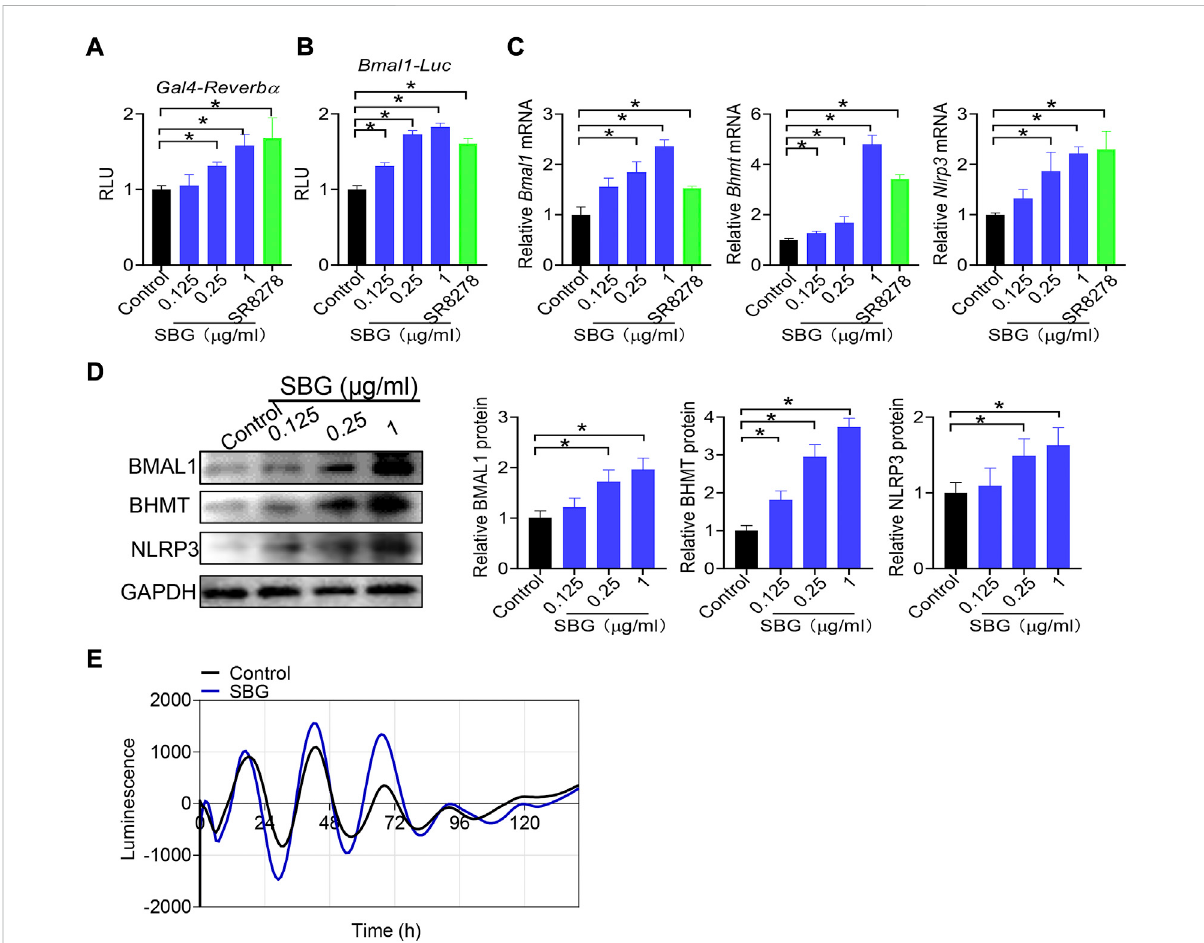
FIGURE 9 SBGantagonizesREV-ERB α toinduceBMAL1expression .(A) Dose-dependenteffectsofSBGonGal4luciferaseactivity.HEK293cellswereco- transfectedwith pGal4- Rev-erb α -LBD and pGL4.35-Luc plasmids for 24 h, followed by treatment with SBG or vehiclefor 24 h. (B) Effects of SBG on Bmal1-Luc reporter activity. (C) Effects of SBG on the mRNA expression of Bmal1, Bhmt and Nlrp3 in NIH3T3 cells treated with SBG or vehicle. (D) EffectsofSBGontheproteinexpressionofBMAL1,BHMTandNLRP3inNIH3T3cellstreatedwithSBGorvehicle. (E) Bioluminescentrecordings of Bmal1-dLuc- overexpressed NIH3T3 cells after SBG treatment. In panels A – B, data are mean ± SD ( n = 6). In panels C – D, data are mean ± SD ( n = 3). * p < 0.05 (one-way ANOVA and Bonferroni post hoc